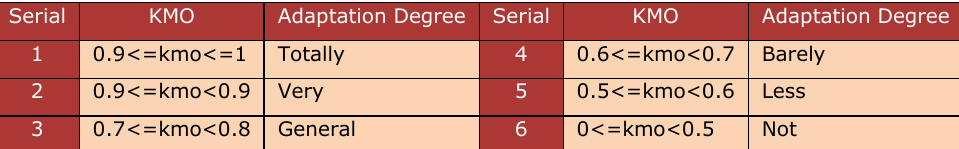
Table 4. Check list of KMO and factor analysis sufficiency